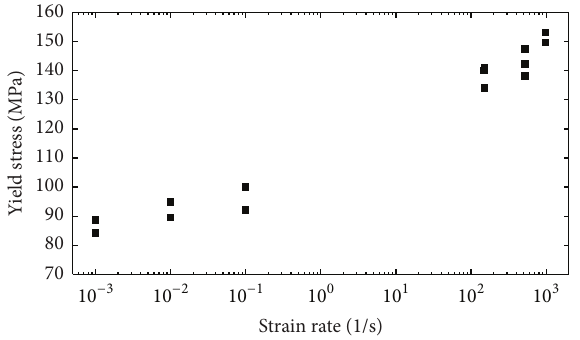
Figure 11: Sensitivity of the yield stress to strain